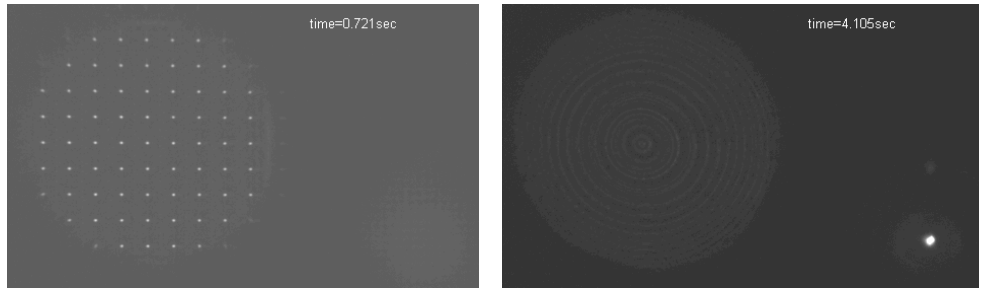
Figure 3. A real time video of the performance of the system when compensating continuously varying amounts of defocus. See the supplementary video for observing the system operating in